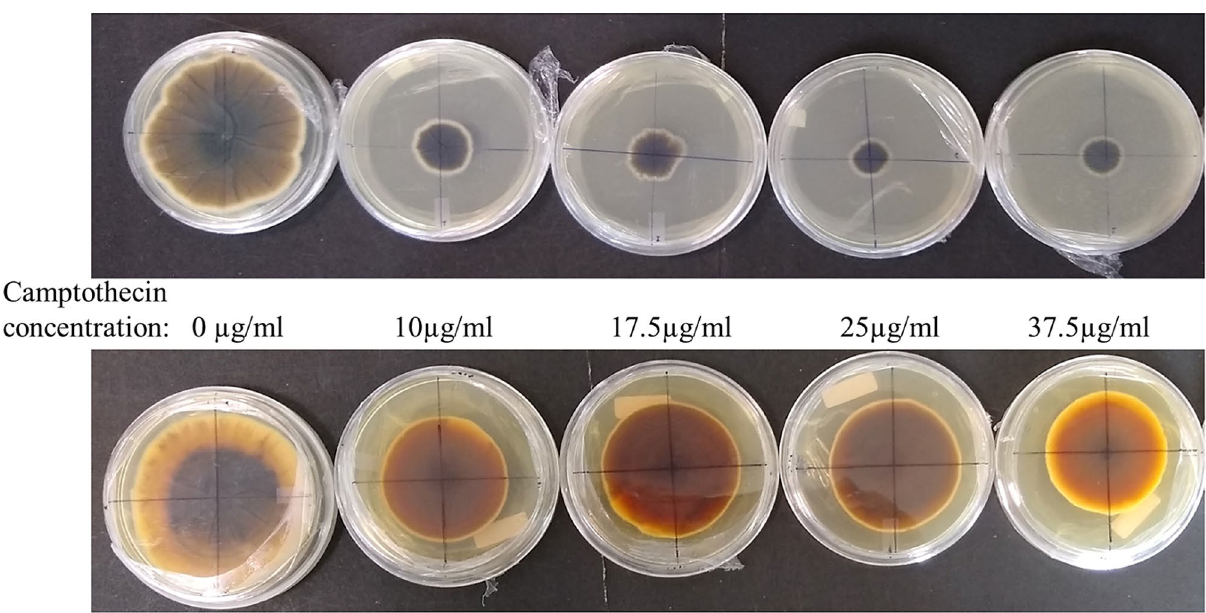
Figure 3. Comparison of camptothecin tolerance in non camptothecin producing strain (NCPT1) (top) with camptothecin producing strain (CPT1) (bottom) in increasing concentrations of camptothecin.